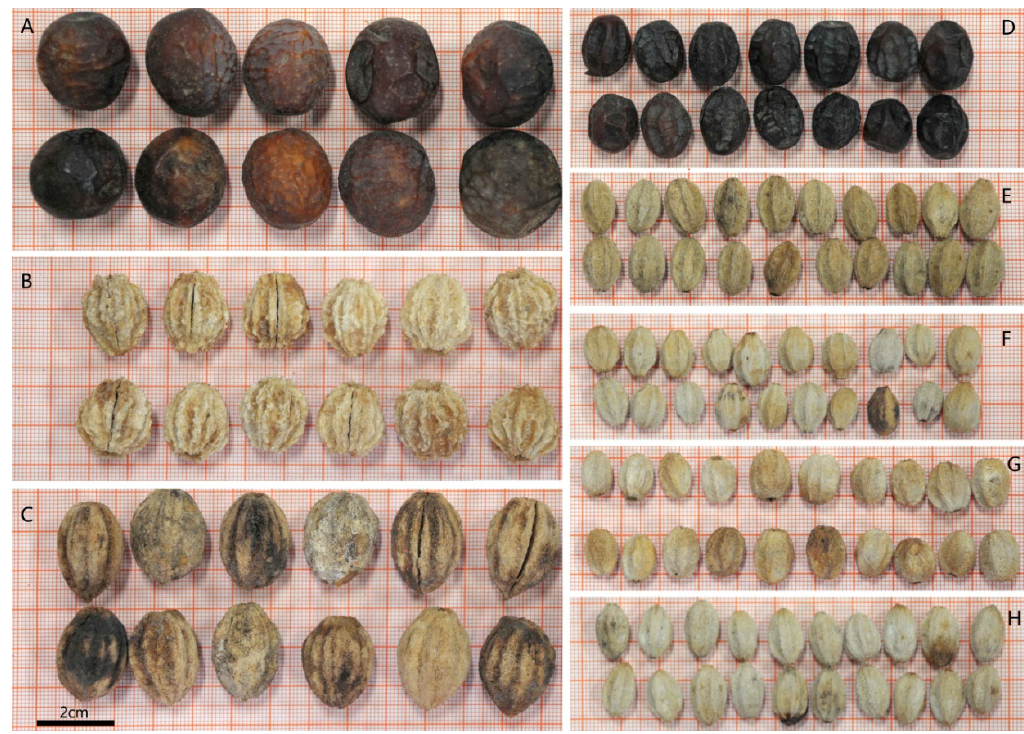
Figure 7. Morphological differences in Melia fruits and stones: ( A )–( C ) for putative M. toosendan ; ( D )–( H ) for putative M. azedarach . The fruits and stones in ( A )–( H ) were collected from the same seed trees in different populations located in: ( A ) Chuxiong; ( B ) Zunyi; ( C ) Mengla; ( D ) Xuchang; ( E ) Tunchang; ( F ) Renhua; ( G ) Tai’an; and ( H )